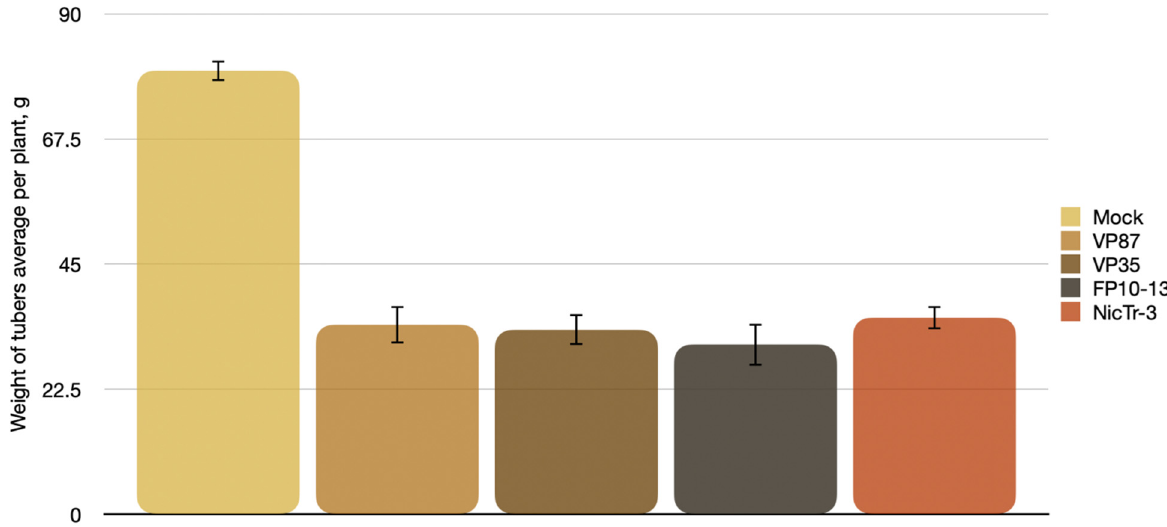
Figure 7. Mean value for the weight of tubers per plant for PSTVd-infected and mock-inoculated plants of 39 potato cultivars. Differences between mock- and PSTVd-inoculated plants are significant according to Student’s t -test with Bonferroni correction, p < 0.05.